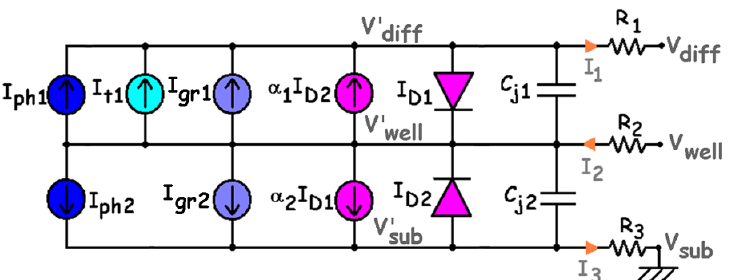
Figure 11. Large-signal equivalent circuit of the BDJ PD.